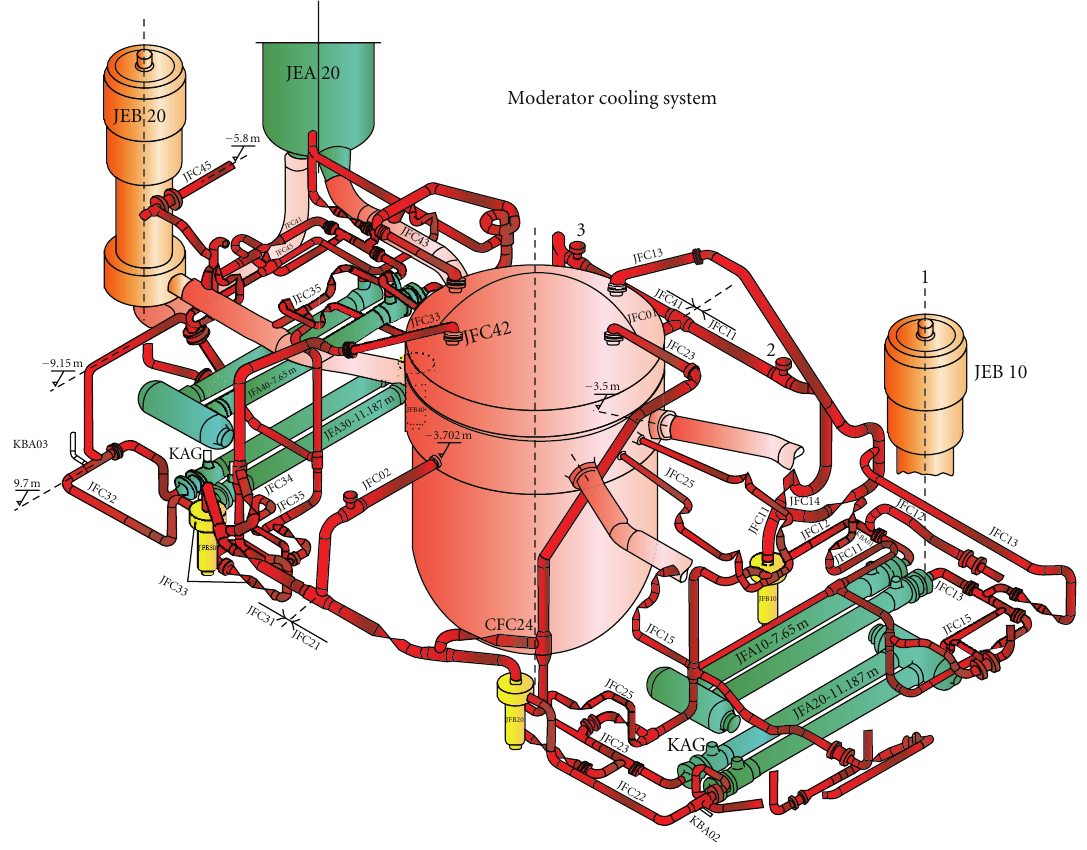
Figure 4: CNA-2 moderator system